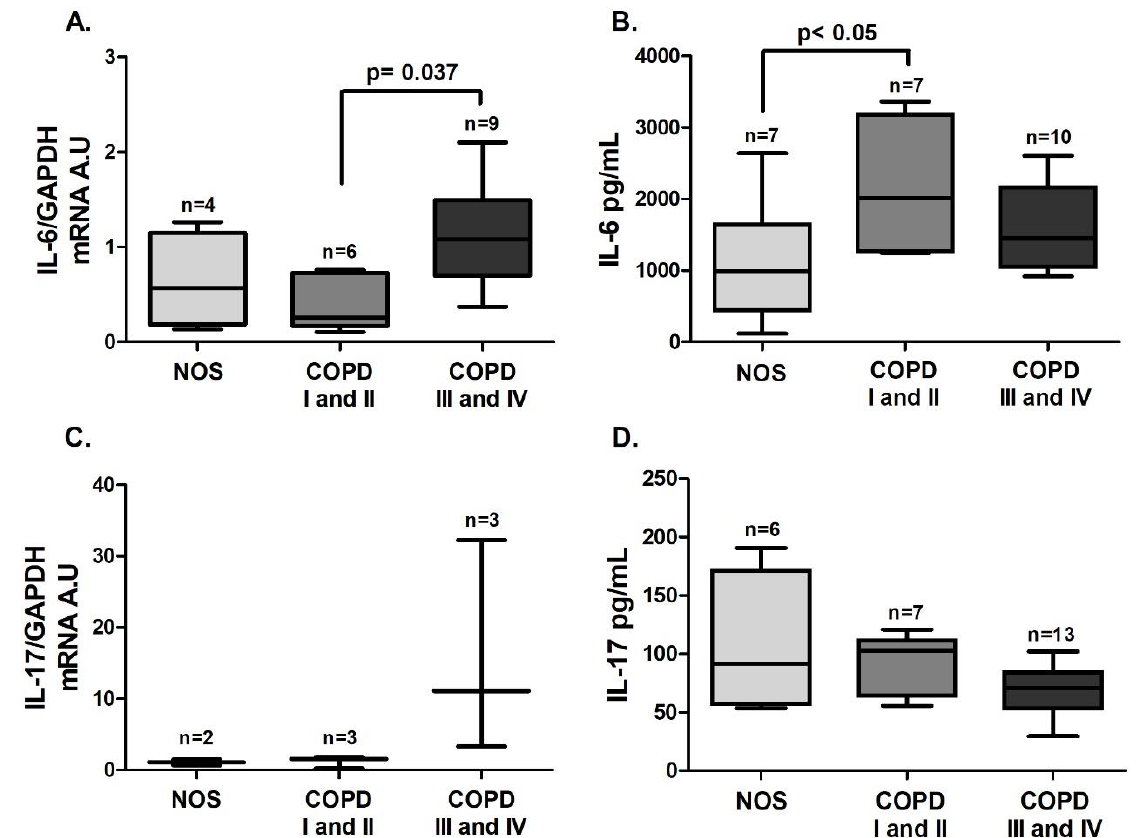
Figure 4. Th17-related cytokines in the systemic response. Th17-related cytokines expression in white blood cells ( A and C ) and plasma samples ( B and D ): ( A ) increased IL-6 gene expression ( p = 0.037, Kruskal–Wallis test) in the COPD III and IV group compared to the COPD I and II group; ( B ) increased IL-6 levels ( p < 0.05, one-way ANOVA) in the COPD I and II group compared to the NOS group. No differences were observed for IL-17 gene expression ( C ) (Kruskal–Wallis test) or IL-17 levels ( D ) (Kruskal–Wallis test) among the groups. The data are expressed as the median and interquartile range. A.U: Arbitrary